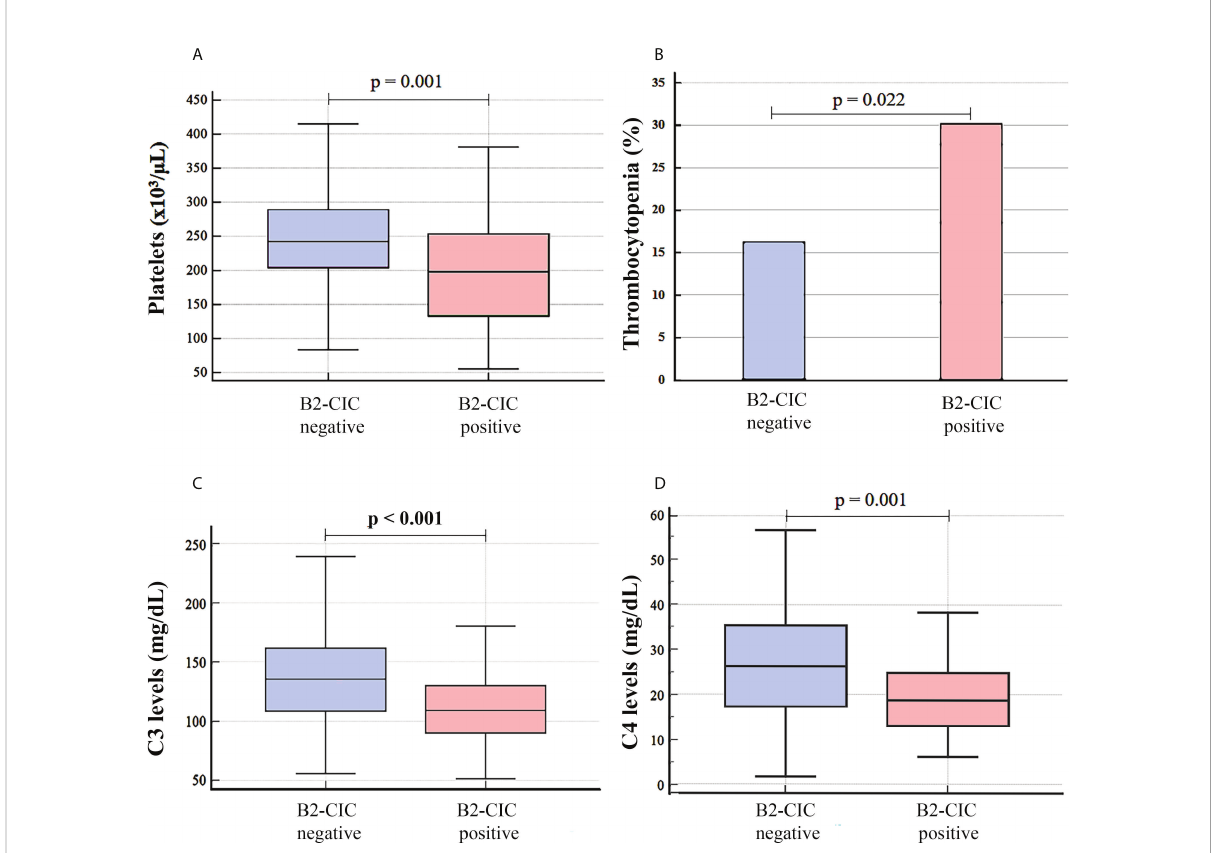
FIGURE 3 Platelet count ( A ), incidence of thrombocytopenia (B) and levels of complement factor C3 (C) and C4 (D) in patients with isolated thrombotic APS, differentiating between B2-CIC-positive and negative patients